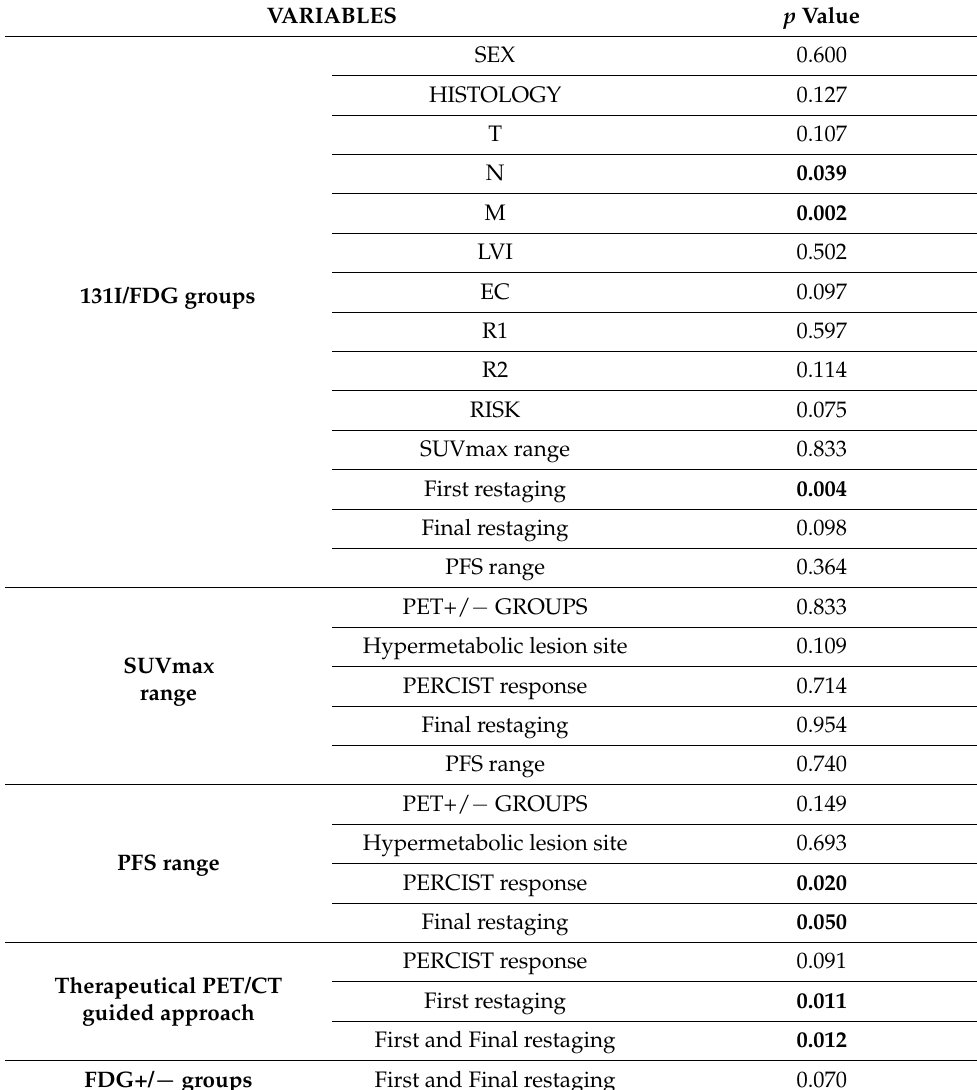
Table 4. Associations between